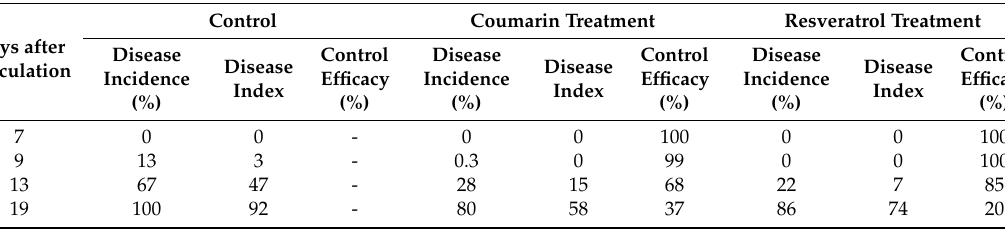
Table 4. Inhibition effects of coumarin and resveratrol against tobacco bacterial wilt under greenhouse. Days after